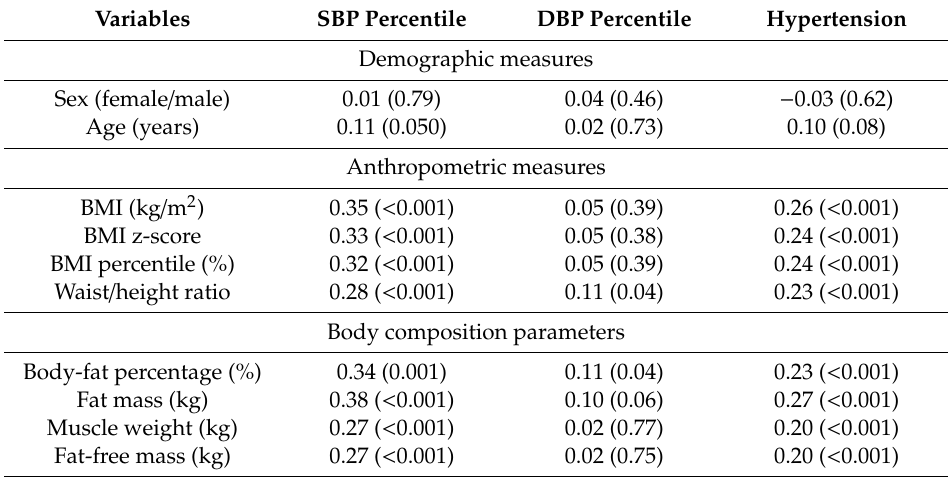
Table 3 summarizes the optimal cuto ff values, AUCs, 95% CIs and p -values of anthropometric measures and BC parameters for predicting pediatric hypertension. A BMI ≥ 18.75 kg / m 2 , fat WHtR ≥ 0.48 and muscle weight ≥ 32.15 kg, in descending order of AUC, could accurately predict pediatric